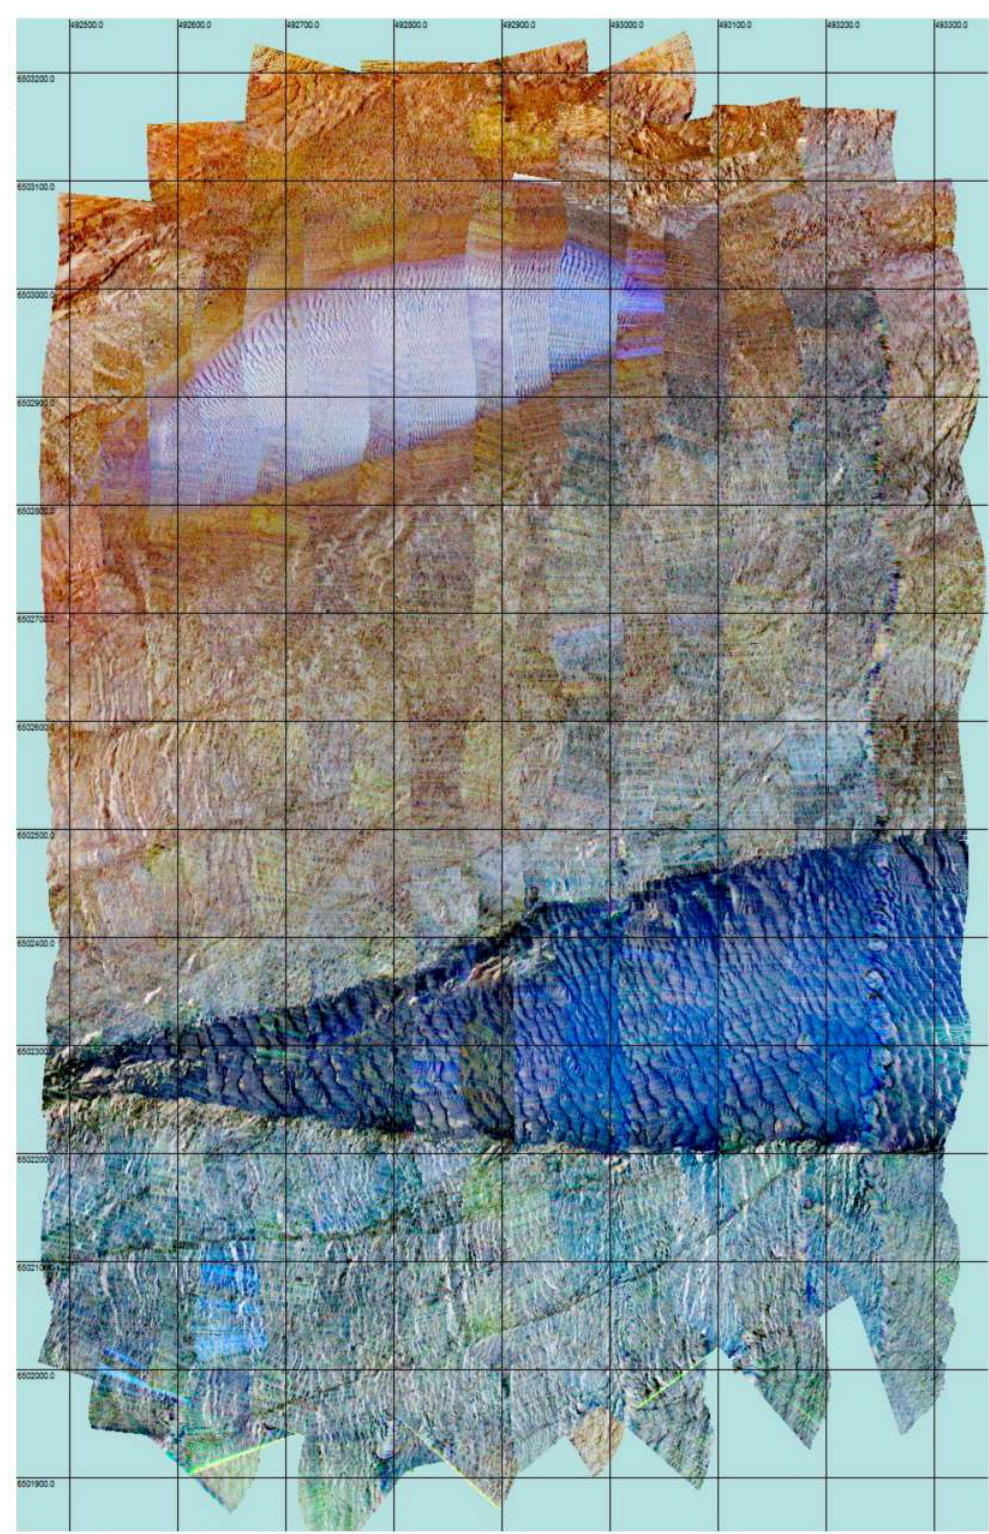
Figure 2. Inner Sound, Pentland Firth. A colour sonar backscatter montage of 15 swaths overlain from west to east (ensonification to the west). Colour was generated using the ‘negative BGR’ colour scheme. The image is frequency equalised. The grid lines are spaced at 100 metre